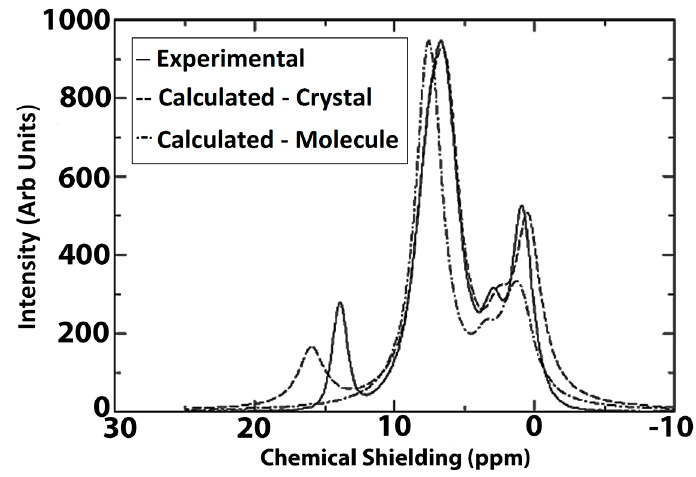
Figure 21. Experimental and simulated, using geometries with only the proton positions relaxed, 1 H-NMR spectrum of flurbiprofen in the solid state. Reprinted, with permission, from [105]. Copyright 2005, The Royal Society of Chemistry.